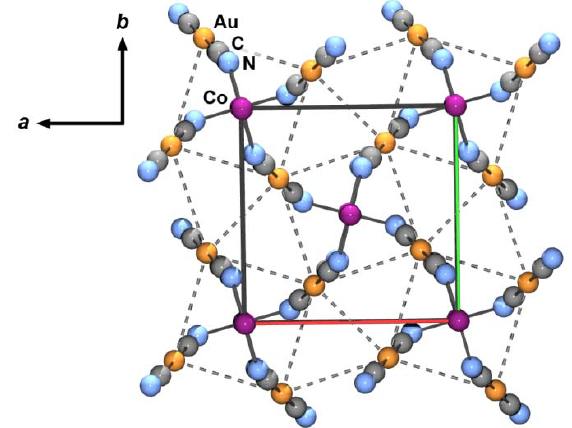
Figure 9. Extended 3-D structure of Co[Au(CN) represent Au-Au